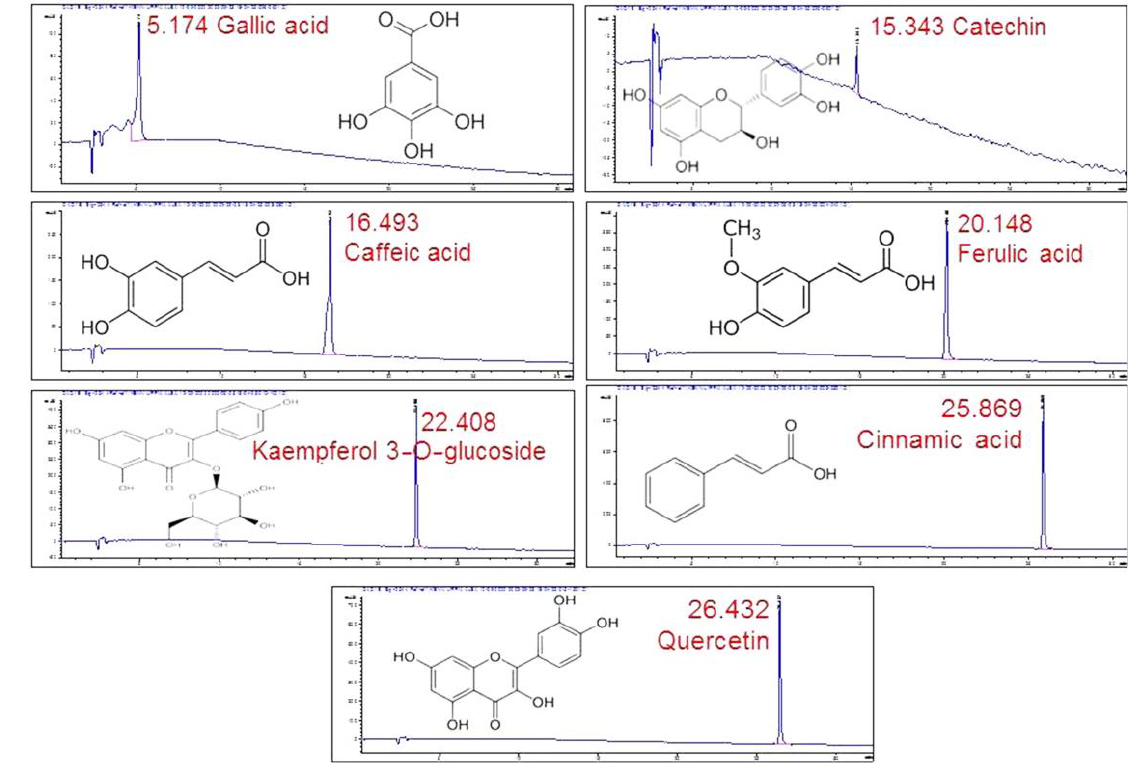
Figure 4. HPLC/DAD profiles of the standards used in the study with their retention times. Table 3. Contents of flavonoids and phenolic compounds in the aqueous extract from the X. caeruleum leaves collected in the vegetative (VE) and flowering (FE) stages.